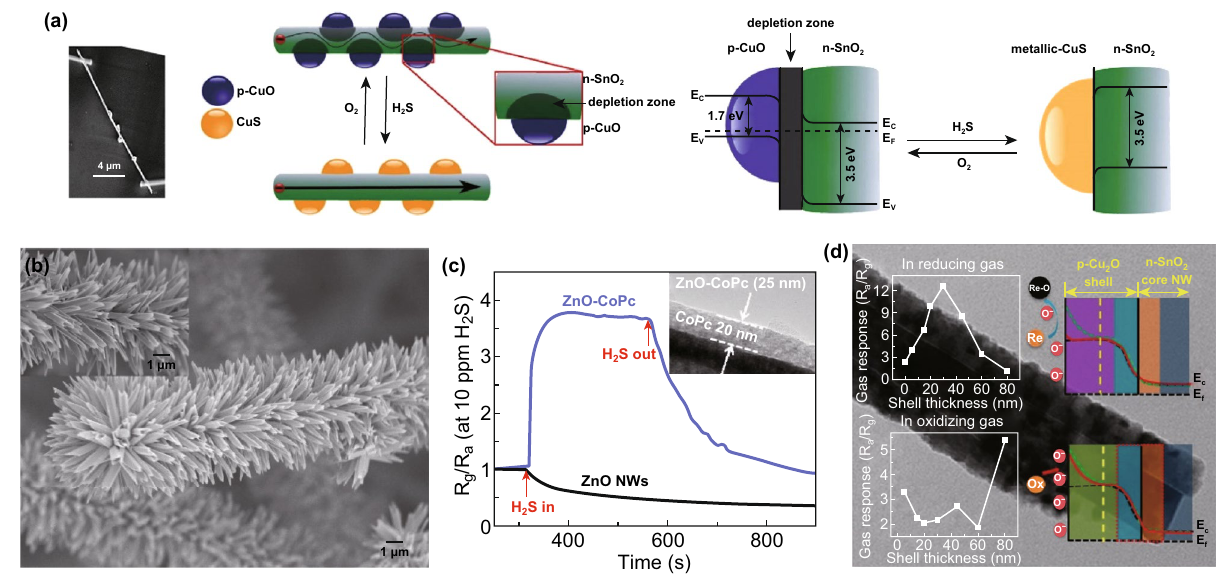
Fig. 12 a SEM image of a single hybrid NW and the schematic illustration of gas-sensing mechanism of CuO–SnO 2 p–n nanowires. Repro- duced with permission [67]. Copyright 2013, Elsevier. b SEM images of the as-grown Te-coated SnO 2 brush-like products prepared at source temperatures of 560 °C. Reproduced with permission [118]. Copyright 2014, American Chemical Society. c The dynamic response-recovery curves for ZnO and n-ZnO/p-CoPc to 10 ppm of H 2 S (the inset is the TEM image of n-ZnO/p-CoPc). Reproduced with permission [119]. Copy- right 2015, American Chemical Society. d TEM image of 1D SnO 2 /CuO nanostructures (left insets are responses to reducing and oxidizing gas as a function of shell thickness, respectively; right insets are the corresponding sensing mechanism). Reproduced with permission [120]. Copy- right 2015, American Chemical